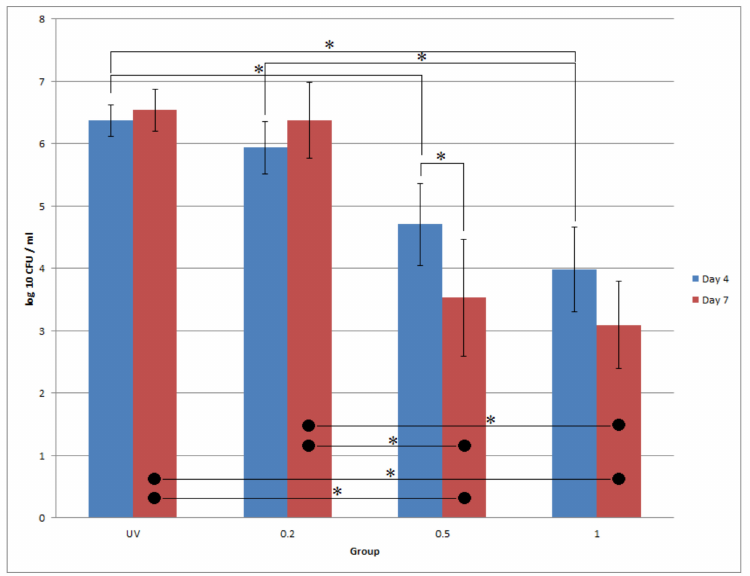
Figure 5. log10 CFU values for different PHMB-Ti with different times. Blue bar: day 4; red bar: day 7. * denotes statistical significance of two groups at α = 0.05 with the Mann-Whitney U